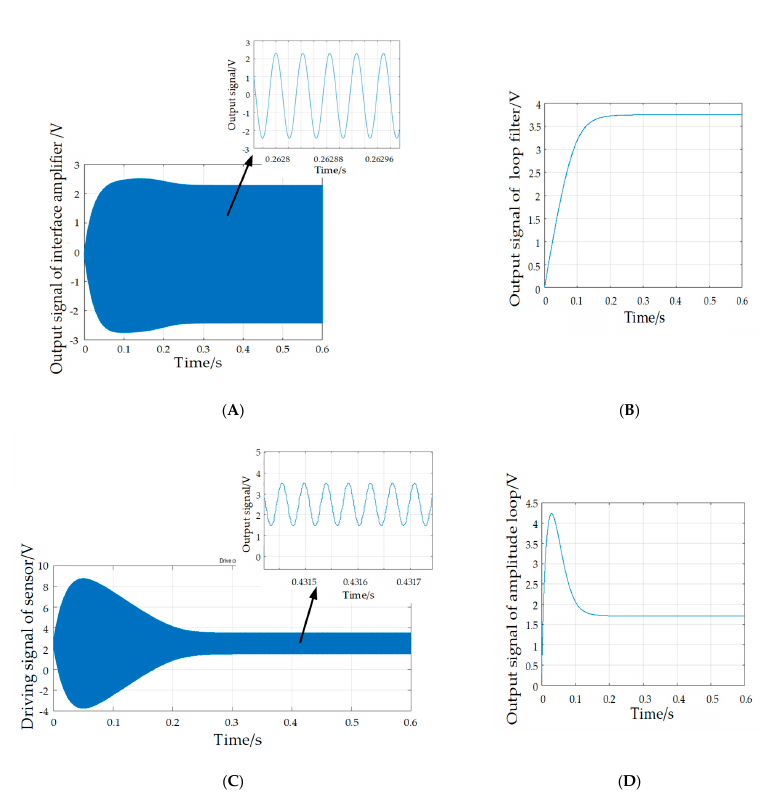
Table 3. Simulation parameters.